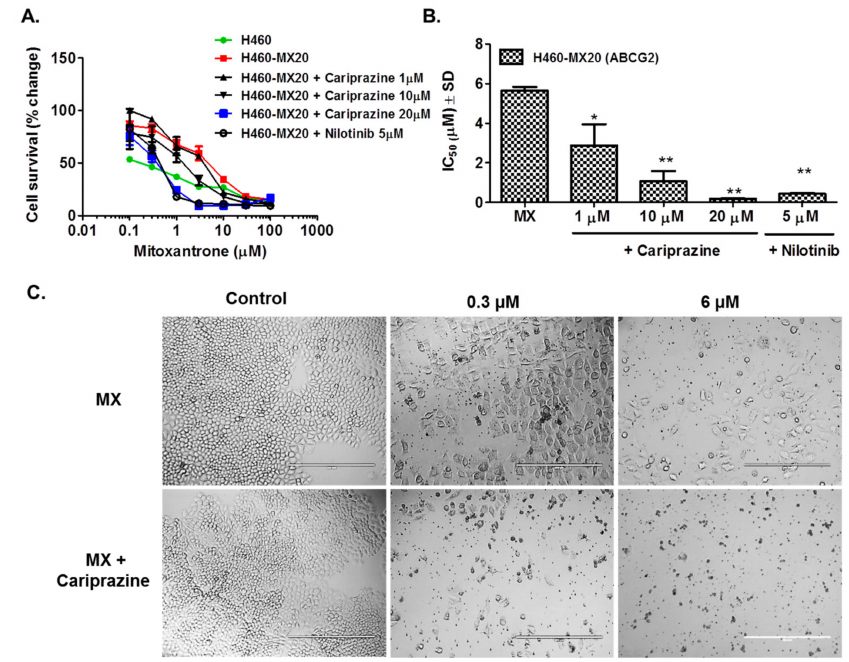
Figure 2. The effect of cariprazine on the efficacy of MX in the ABCG2 overexpressing cell line H460-MX20. ( A ) MTT cytotoxicity is expressed as the percentage change in cell survival. ( B ) The IC 50 values for MX alone (control) or in combination with different concentrations of cariprazine or with 5 µ M of nilotinib. ( C ) Microscopic images illustrating the synergistic effects of cariprazine on the efficacy of MX at different concentrations. Scale bar: 20 × . The data points represent the means ± SD of at least three independent experiments, each with triplicate determinations. * p < 0.05; ** p < 0.01 vs. control cells incubated with MX